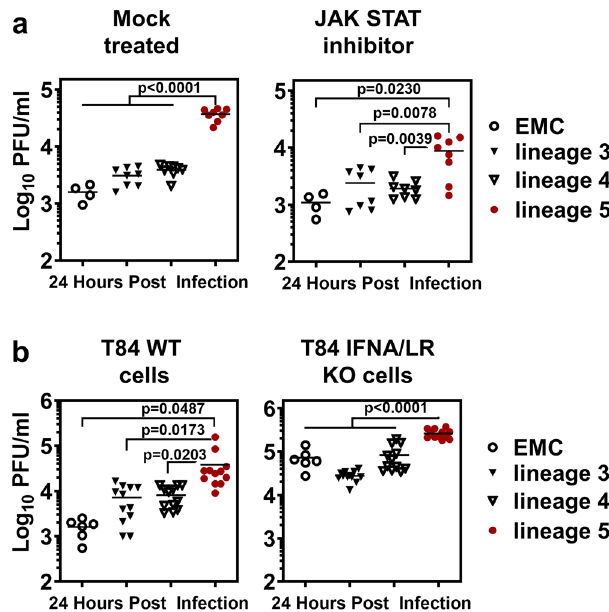
Fig. 9 Replication of MERS-CoV isolates in JAK/STAT signaling inhibited and IFN receptor knockout cells. Higher replication of lineage 5 MERS-CoV is additionally linked to IFN action via the JAK/STAT signaling pathway. a Calu-3 cells were treated with 50 nM of the JAK/STAT inhibitor Ruxolitinib 1 h prior and during the infection with viruses of the indicated phylogenetic lineages. Virus progeny in the culture supernatant was quanti fi ed by plaque assay at 24 hpi. Infections were performed in biological duplicates with n = 2 virus isolates per lineage and the experiment was repeated two times. Statistical signi fi cance of differences in virus replication between lineage 5 and lineage 3 or 4 or EMC was analyzed by two-tailed, unpaired t -tests. b T84 wt and type I and III IFN receptor knockout cells (IFNAR/IFNLR KO cells) were infected with viruses of the indicated phylogenetic lineages and virus progeny in the supernatant was quanti fi ed by plaque assay at 24 hpi. The infections were performed in biological duplicates with n = 2 virus isolates per phylogenetic lineage and the experiment was repeated two times. Statistical signi fi cance of differences in virus replication between lineage 5 and lineage 3 or 4 was analyzed by two-tailed, unpaired t